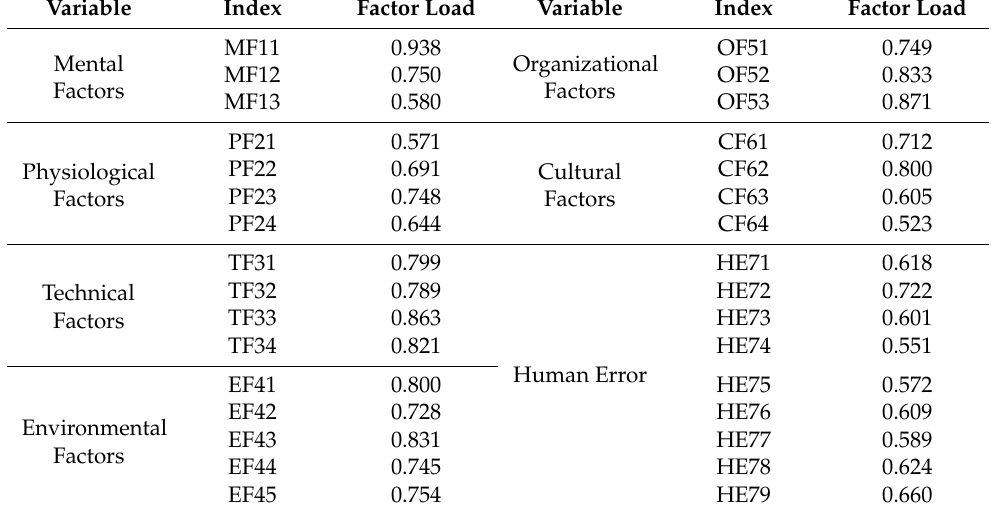
Table 5. Value of factor